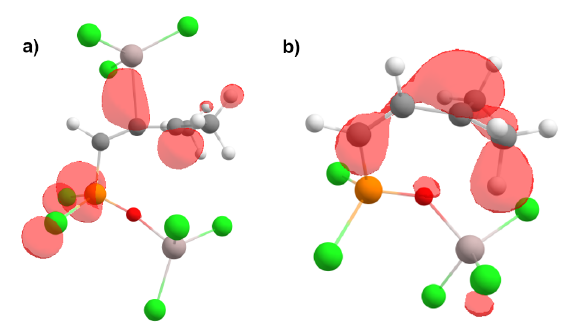
Figure 4: Visualization of LUMO, only positive values are shown, isosurface value 0.043: (a) species 16 , (b) species 22 .